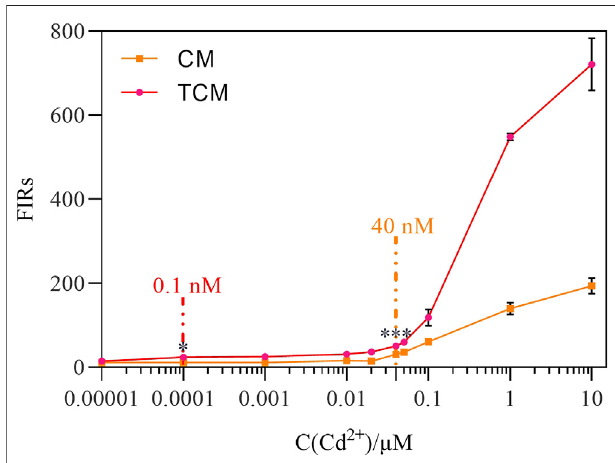
FIGURE 4 | Dose-dependent fl uorescence response of the biosensor CM without negative feedback and biosensor TCM with negative feedback. The error bars represent the standard deviations from triplicate experiments. * p < 0.05; ** p < 0.01; *** p < 0.001.